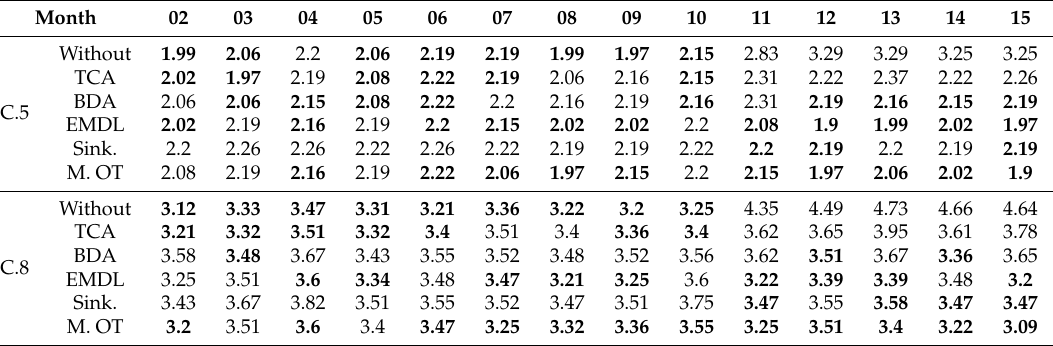
Table 3. The performance of the transfer learning algorithm on the measured FL data set (out of sample